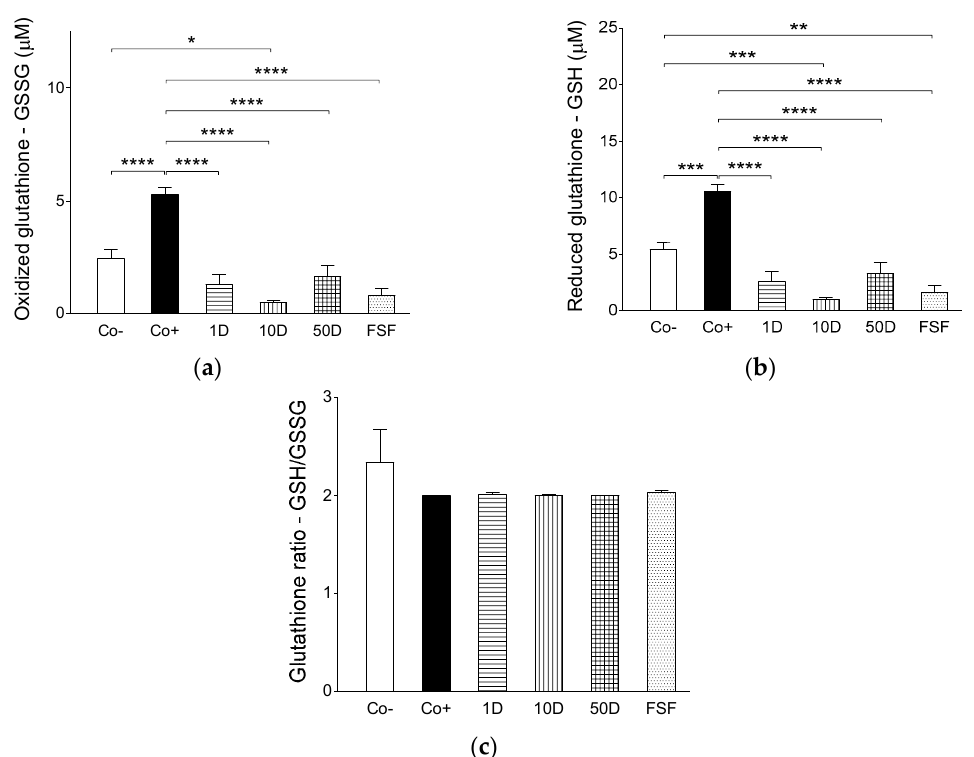
Figure 4. The effect of high-fat, high-sugar diet (HFHSD) (positive control: Co+), 2 g/kg bw/day fenugreek seed flour in addition to HFHSD (FSF), 1, 10 and 50 mg/kg bw/day diosgenin in addition to HFHSD (1D, 10D and 50D, respectively) on plasma levels of the oxidized ( a ) and reduced ( b ) forms of glutathione, furthermore on the ratio of reduced to oxidized glutathione ( c ) in Wistar rats. The negative control group (Co − ) consisted of rats receiving conventional rat food and tap water. The columns represent the average values of the given groups (+SEM). Asterisks indicate the significance level of differences between groups (*: p < 0.05; **: p < 0.01; ***: p < 0.001; ****: p < 0.0001).